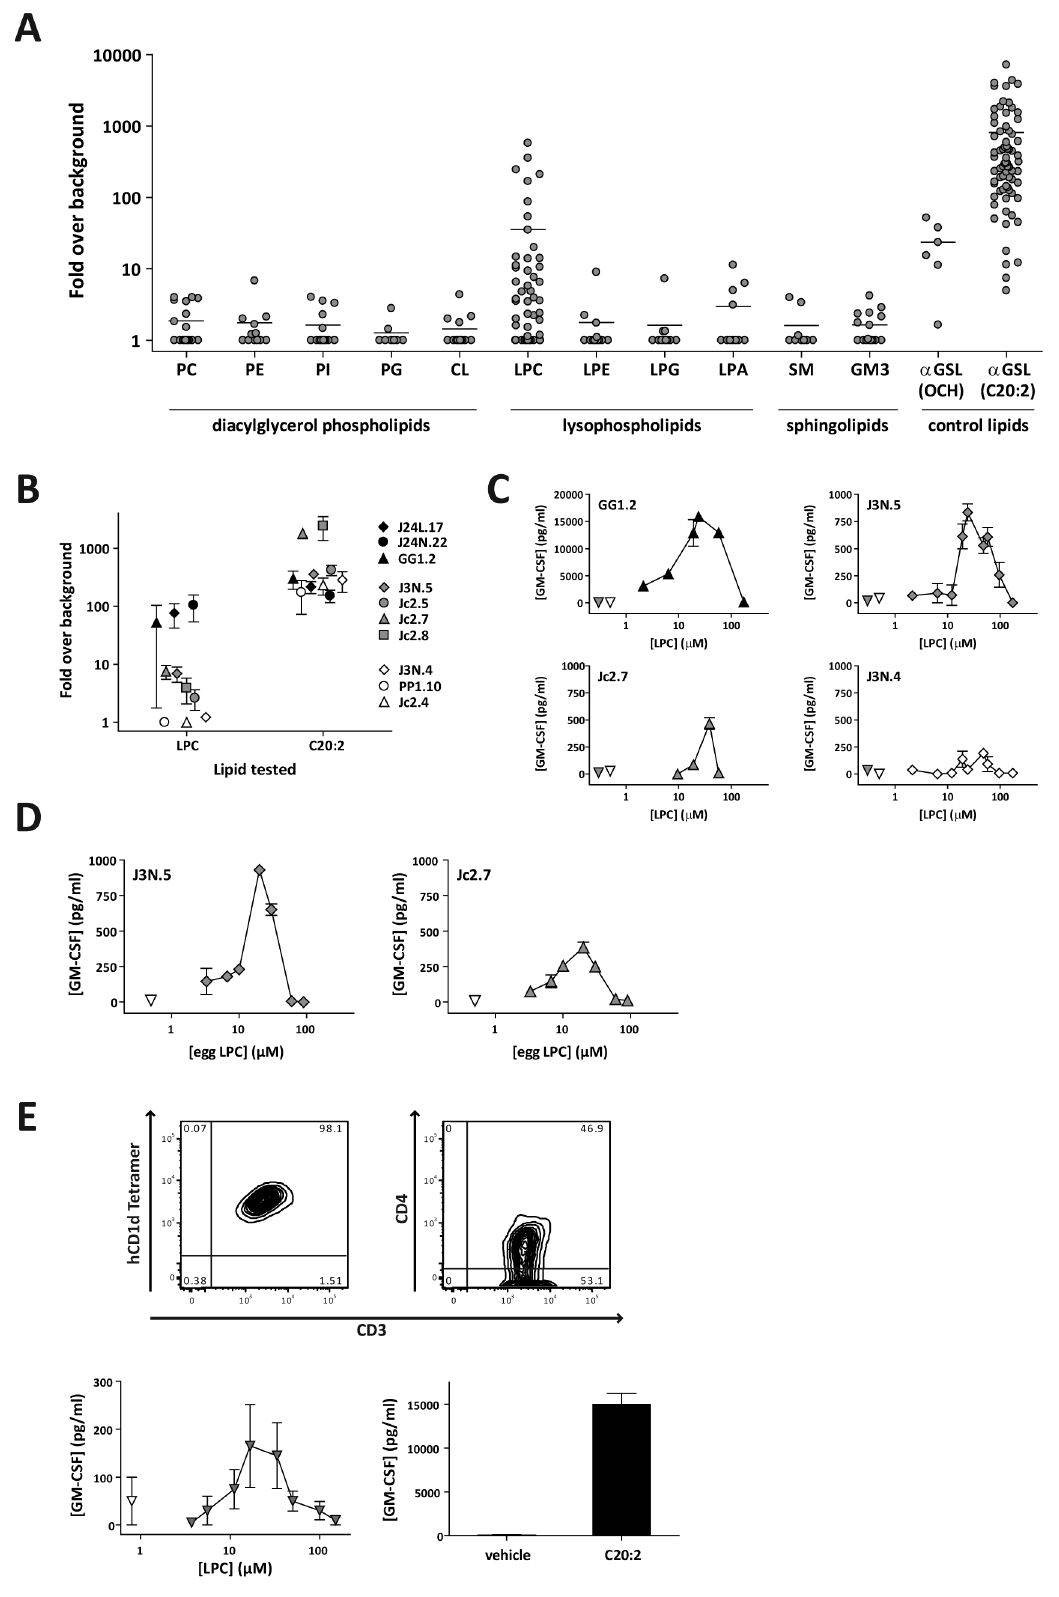
Figure 1. NKT cell recognition of LPC. (A) Human NKT cell clones were tested for cytokine secretion in response to immobilized recombinant CD1d molecules that were pulsed with lipid species that were found among the ligands eluted from human CD1d molecules [25]. Two a - galactosylsphingolipids ( a -GSL OCH and C20:2) were tested in parallel as controls. Each dot represents an individual NKT cell clone’s response to the